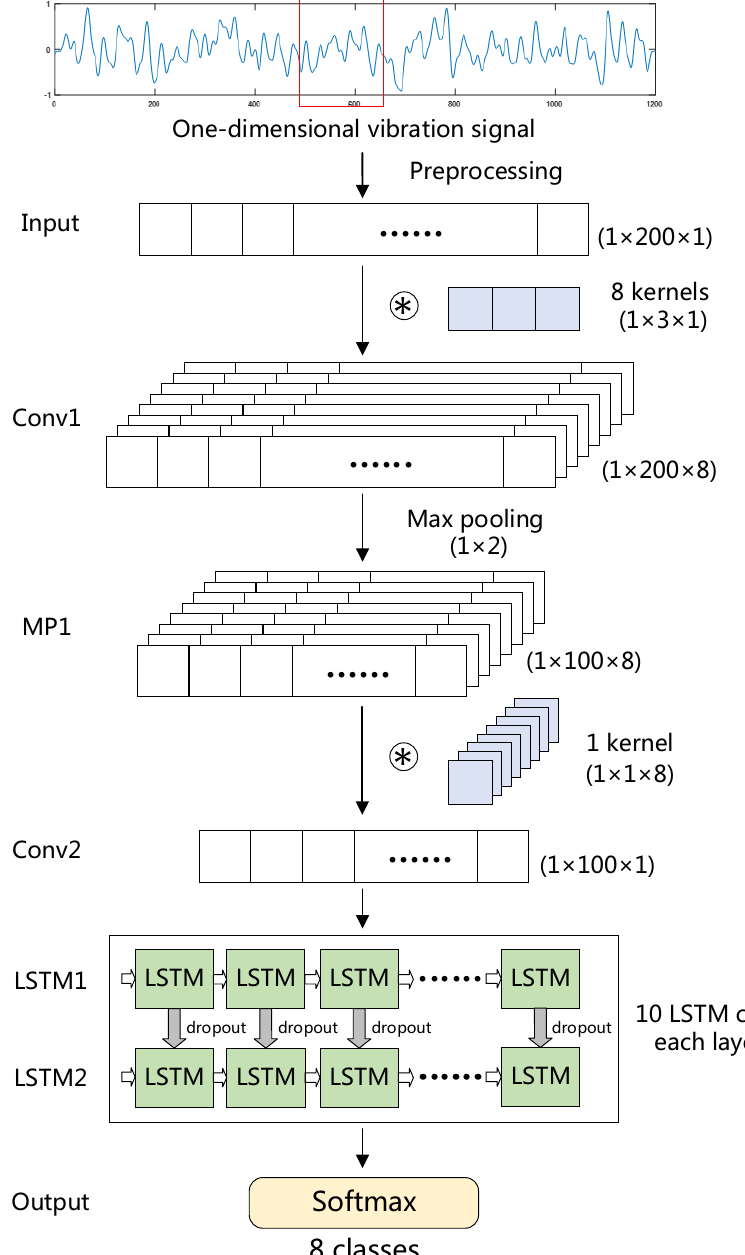
Figure 3. The overall structure of 1DCL. The marker ∗ (cid:13) denotes convolution